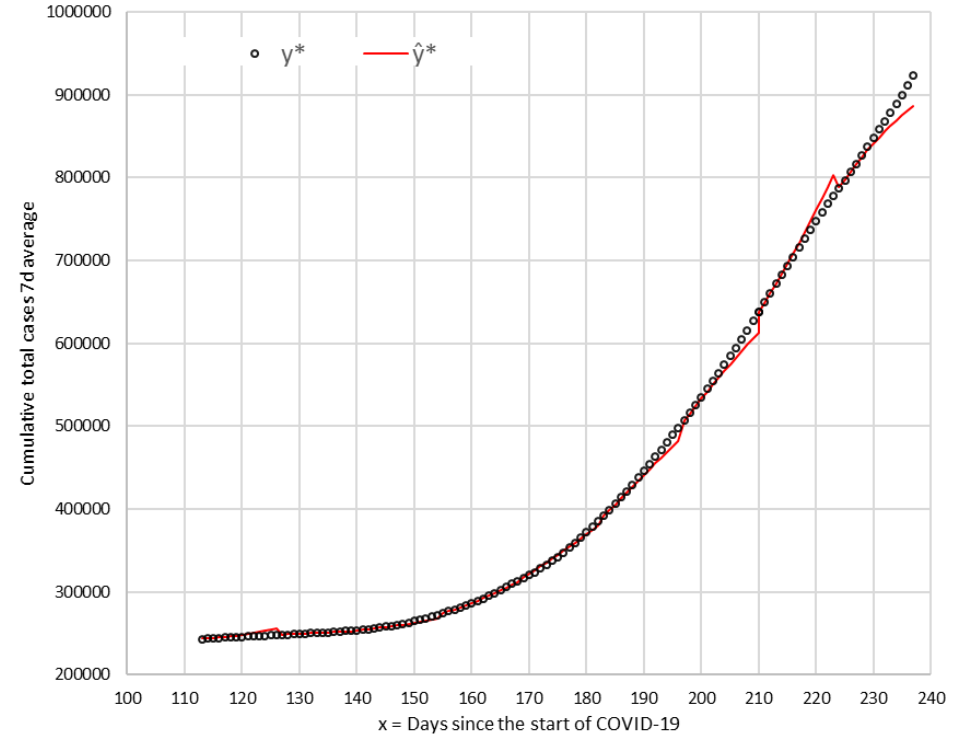
Figure 5. Predictive arcs (red line) calculated from 15 June (x = 113) to 17 October (x = 237). The black circles represent all the observed values of cumulative number of cases for a seven day